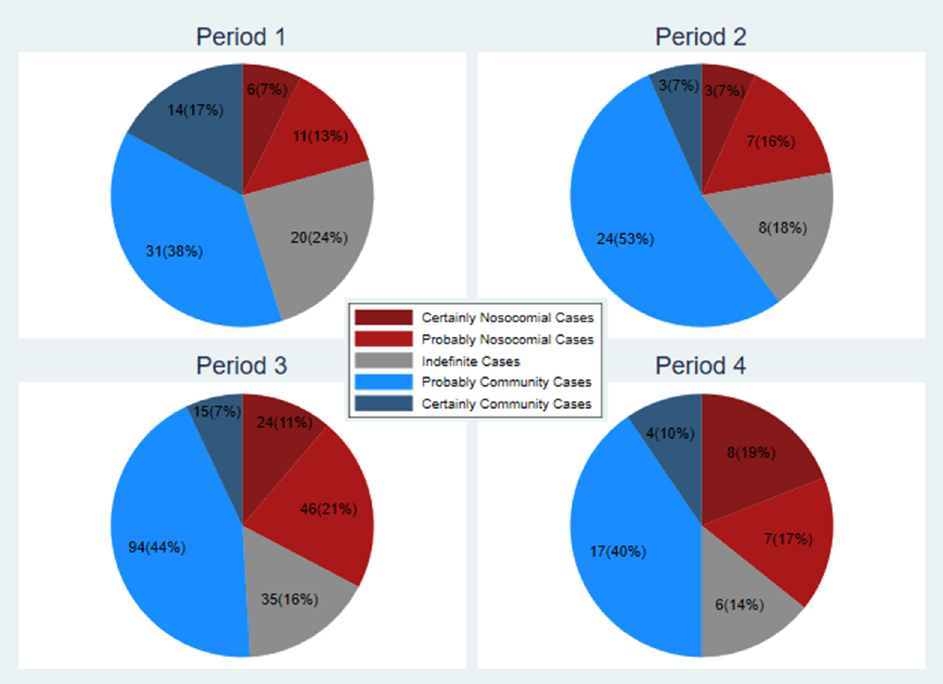
Figure 1. Representation of the cases divided into five classes and divided into different phases of analysis.